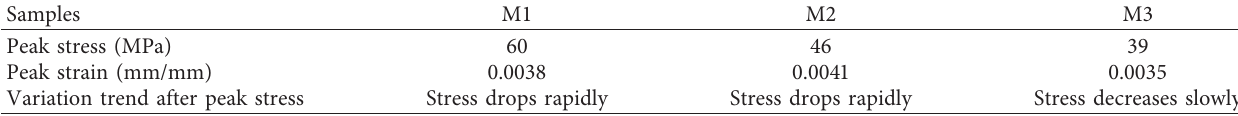
Table 5: Stress-strain curves for different geopolymers at room temperature.